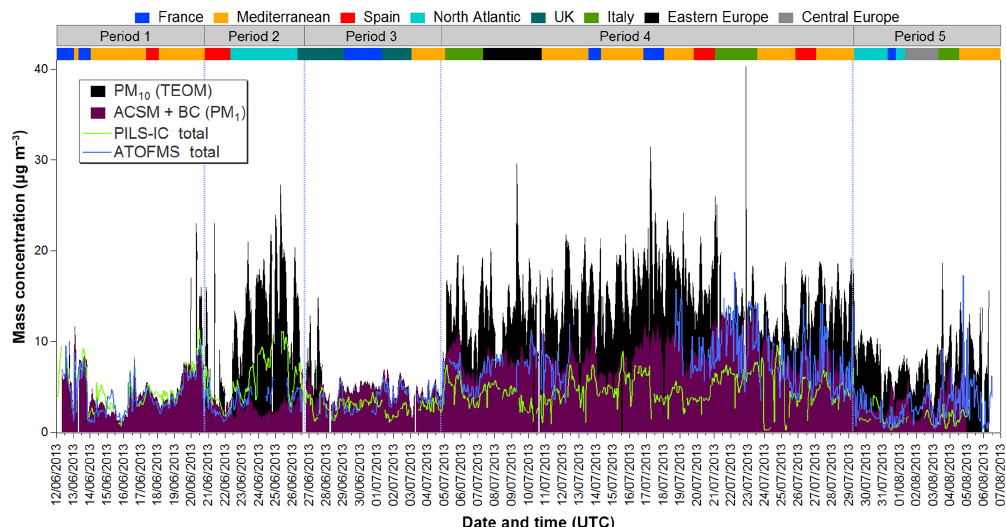
Figure 2. Hourly mass concentrations of PM 10 , total ACSM species + BC (PM 1 ) , total PILS-IC species (PM 10 ) and total ionised ATOFMS particles during ADRIMED and